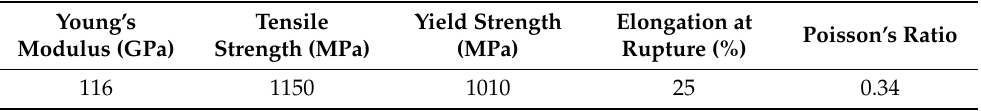
Table 1. Mechanical properties of Ti-6Al-4V titanium alloy [26,30], the construction material of MSC-Scaffold prototypes manufactured using SLM.